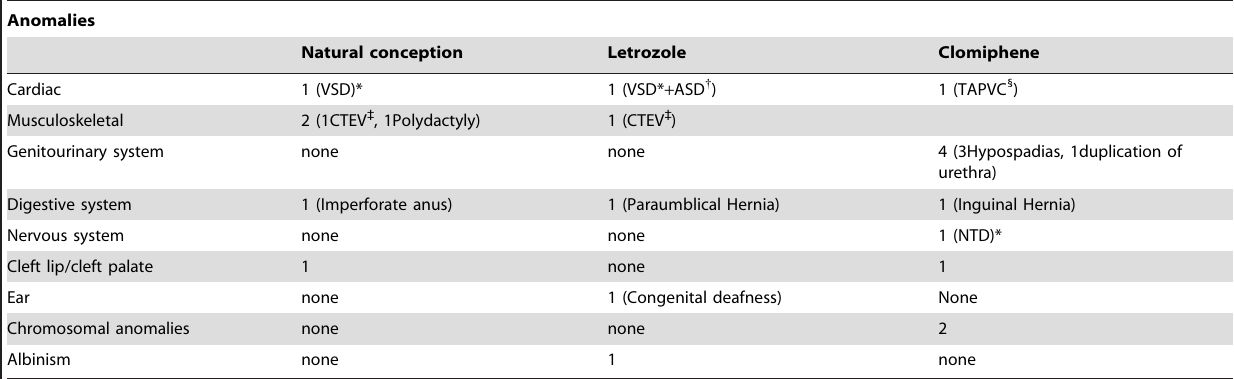
Table 3. Congenital anomalies in different